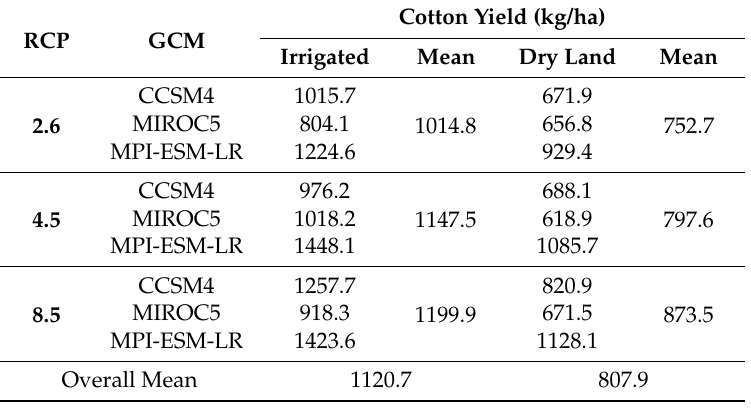
Table 7. Mean annual irrigated and dryland cotton yields for future climate scenarios (2016–2040). The irrigated average annual yields are significantly greater than the dryland mean yields ( p =